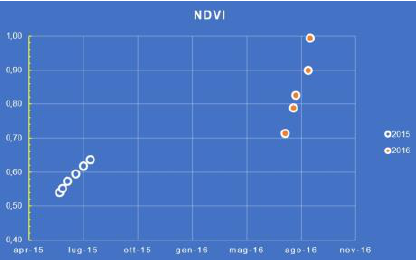
Figure 8. Acquisition by FLIR thermal camera